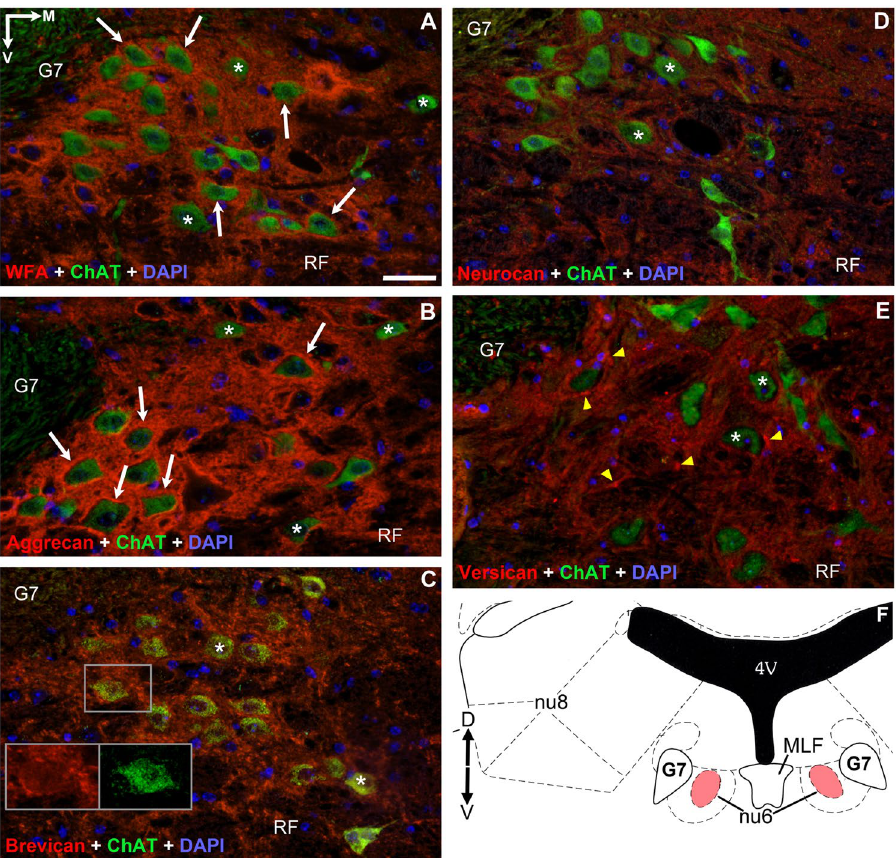
Figure 3. Pattern of chondroitin sulfate proteoglycans around acetyl-cholinergic motoneurons in the abducens nucleus . PNNs were only immuno-positive with WFA and aggrecan labeling (white arrows) ( A , B ). PNNs were absent around only the minority of cholinergic motoneurons labelled with WFA and aggrecan ( A , B ), and were entirely absent with brevican, neurocan and versican immuno-staining (asterisks) ( C – E ). Somata in ( C ) appear in yellow tone resulted by the co-labelling of cytoplasmic brevican and acetylcholine. In ( E ) dot-like accumulations of versican characterized the neuropil (yellow arrowheads). ( F ) Position of abducens nucleus (nu6) in the pons (modified after Paxinos & Franklin, 2001) 4V: 4th ventricle. MLF: medial longitudinal fasciculus. G7: facial genu. RF: reticular formation. nu8: vestibular nuclei. D: dorsal. V: ventral. M: medial. Scalebar: 10